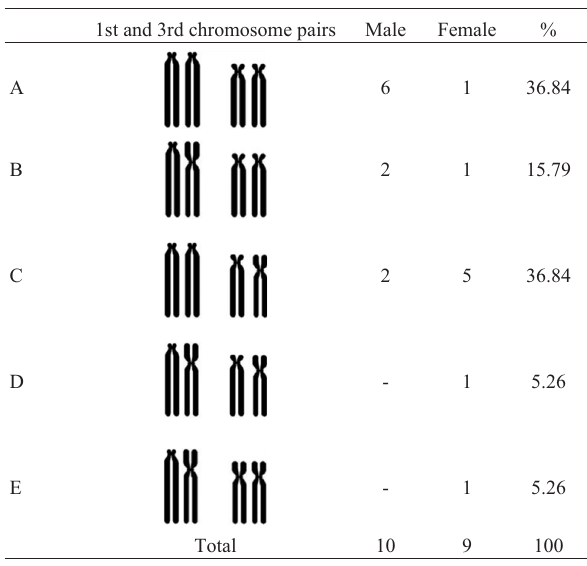
Figure 1 - Classical cytogenetics techniques in Synallaxis frontalis (SFR). (A) Conventional staining of metaphases from a male; arrows indicate the sexual chromosome Z. (B) Partial karyotype containing macrochromo- somes, microchromosomes, and sex chromosomes. (C). C-banding of a female showing the W sex chromosome, entirely heterochromatic. (D) Five distinct cytotypes found in samples. Table 1 - Cytotype frequency in Synallaxis frontalis